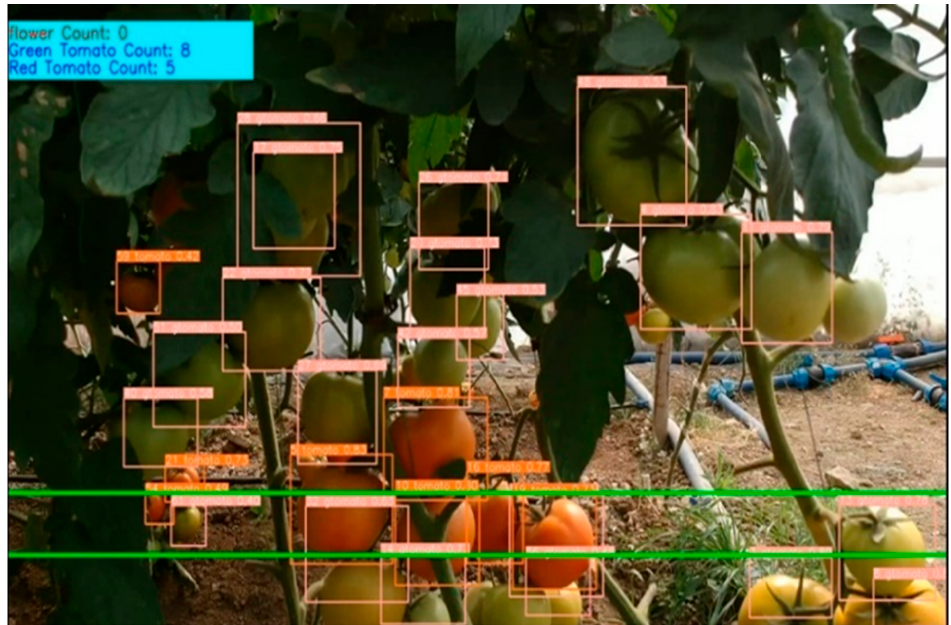
Figure 12. Obtained test results batch with accuracy for Tomato detection model. Here, pink and orange bounding boxes represent green tomato and red tomato classes, respectively. The green lines indicate the in-out counting borders.